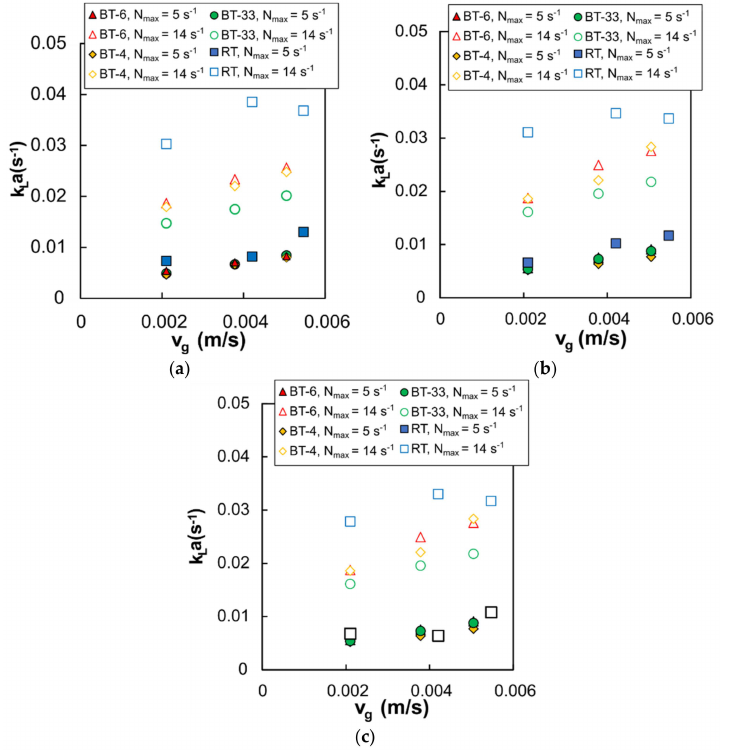
Figure 6. Relation between volumetric mass transfer coefficient k L a and superficial gas velocity v g for BT-33, BT-4, BT-6, and RT impellers: ( a ) f = 0.23 Hz, ( b ) f = 0.46 Hz, ( c ) f = 0.92